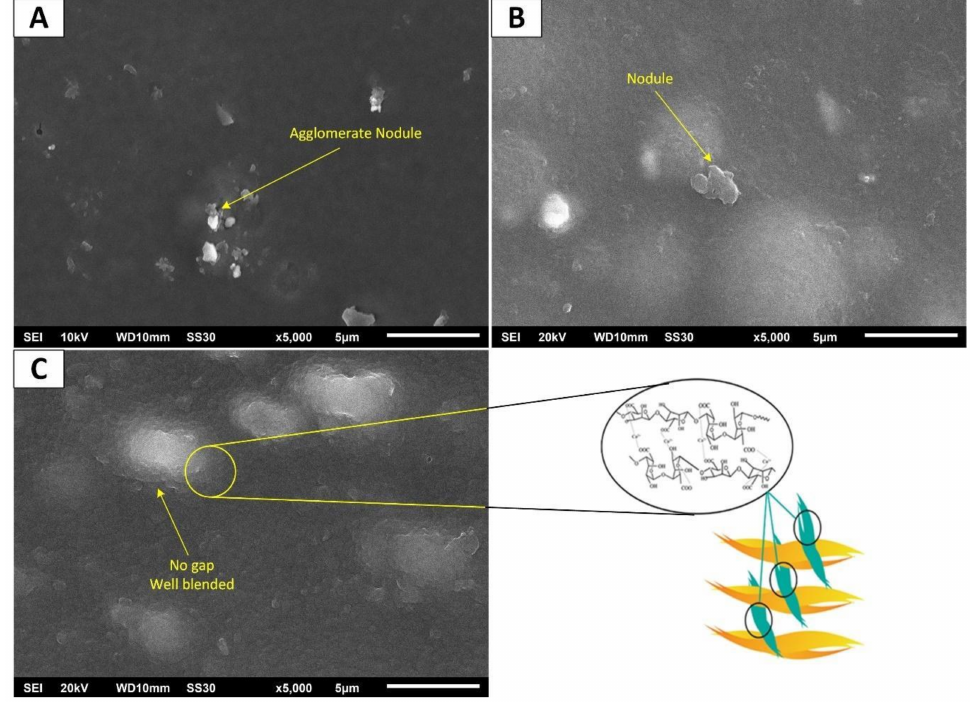
Figure 2. Surface scanning electron microscope (SEM) image of ( A ) pristine sodium alginate (SA) film; ( B ) sodium alginate/k-carrageenan (SA/KC) film; ( C ) Ca crosslinked SA/KC